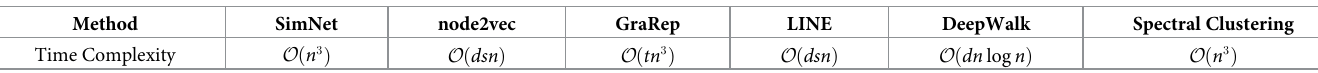
Table 5. Comparison of network embedding methods in terms of complexity in